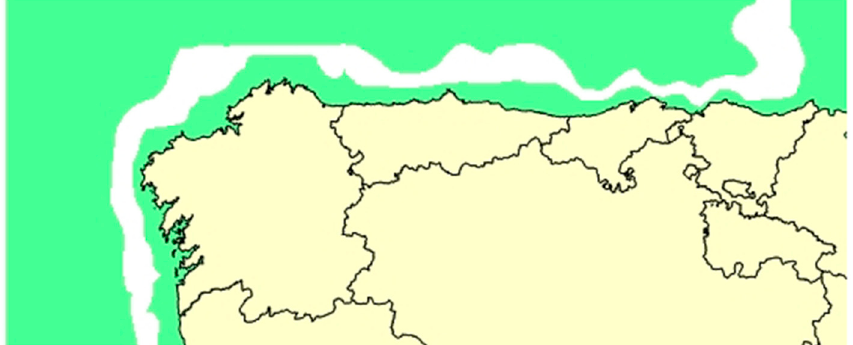
Figure 8. Bathymetry restriction for the TLP platform.